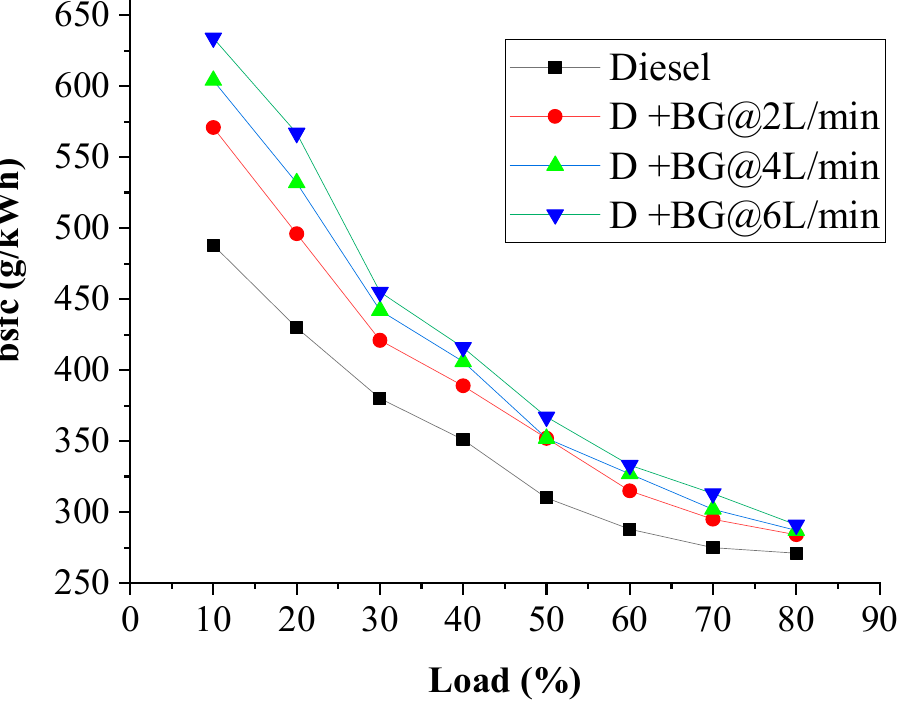
Figure 6. Variation of bsfc with respect to engine load.